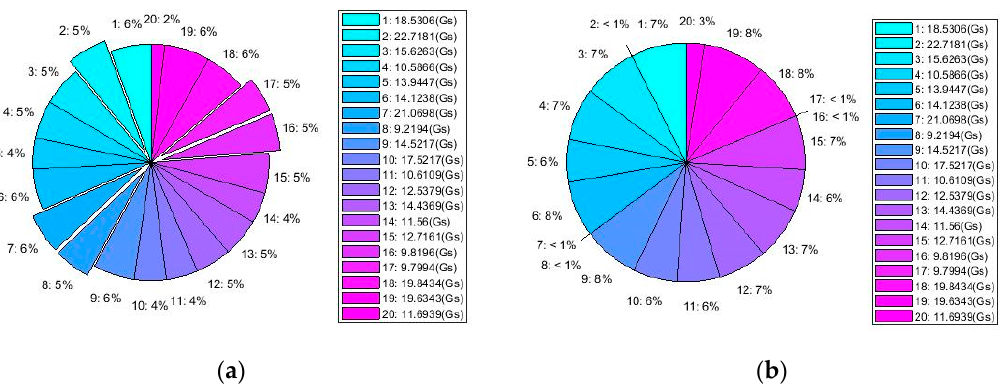
Figure 4. The penalty function adjusts the roulette probability for individuals in the population: ( a ) the roulette probability before the adjustment and ( b ) the roulette probability after the adjustment.